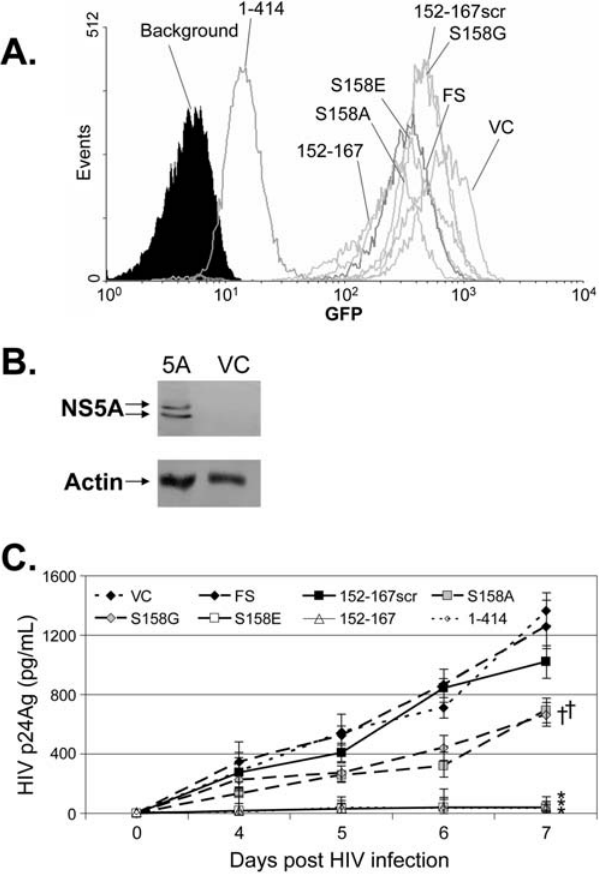
Figure 3. Mutational analysis of GBV-C 152–167 NS5A peptide. Clonal cell lines stably transfected with NS5A peptides were selected by hygromycin resistance and examined for GFP expression (A). Cells expressed the full length NS5A protein (amino acids 1–414), an NS5A